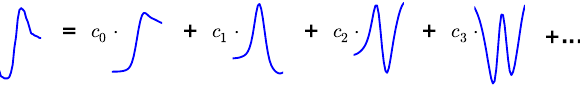
Figure 5 . Representation of a time series snippet around the location of a singularity with its principal shapes pro- cessed by the principal component analysis. The left side of this equationlike representation is the horizontal position in a 60 ms time window around an identified singularity. Here, it is defined by the linear combination of principal shapes. We identified that already two shapes are sufficient to repre- sent roughly 95% of the variances contained in each individ- ual shape. The coefficients c 0 , c 1 ,... are individual for each binocular singularity and explain the contribution of the